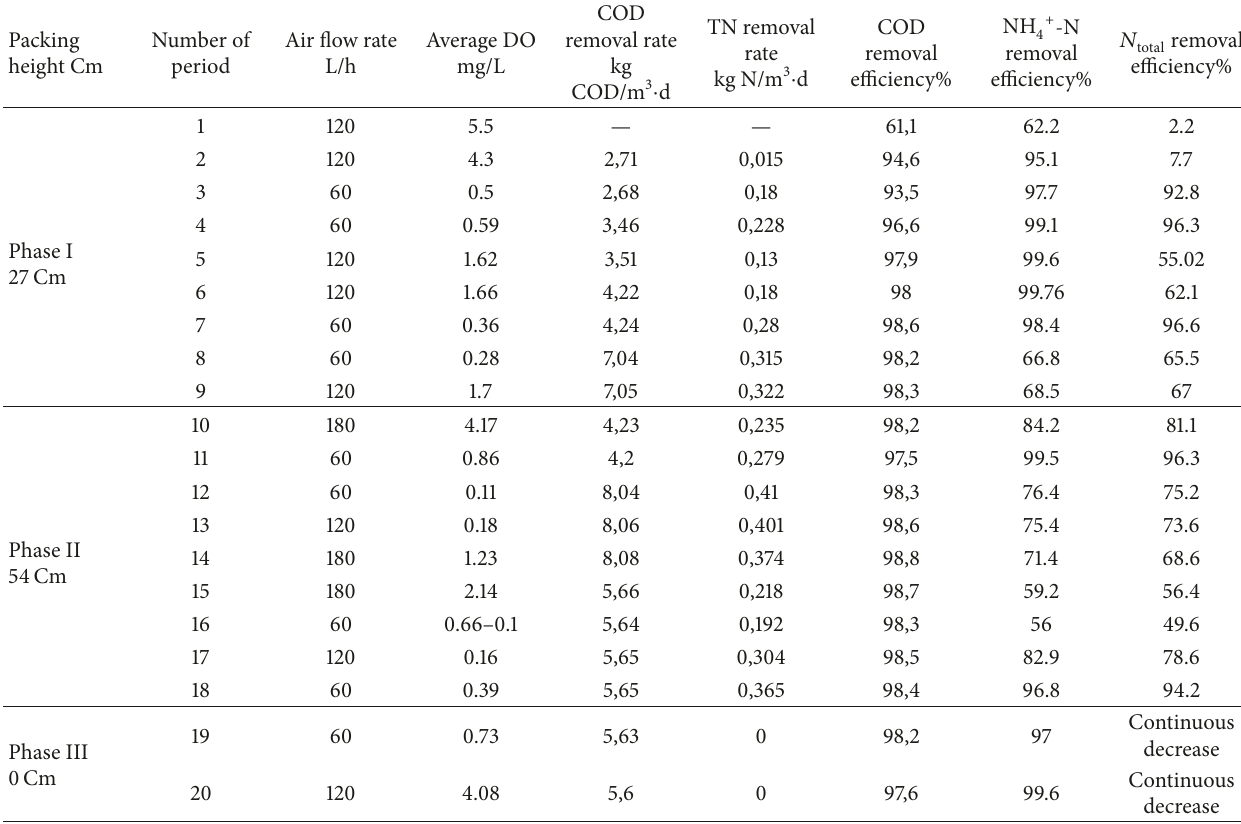
Table 3: Experimental removal rates and removal